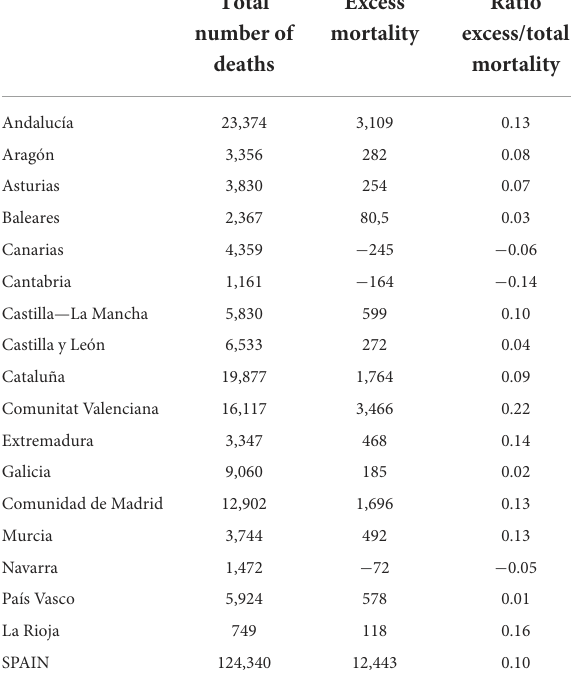
TABLE 2 Total number of deaths and registered excess mortality from 1 January to 31 March